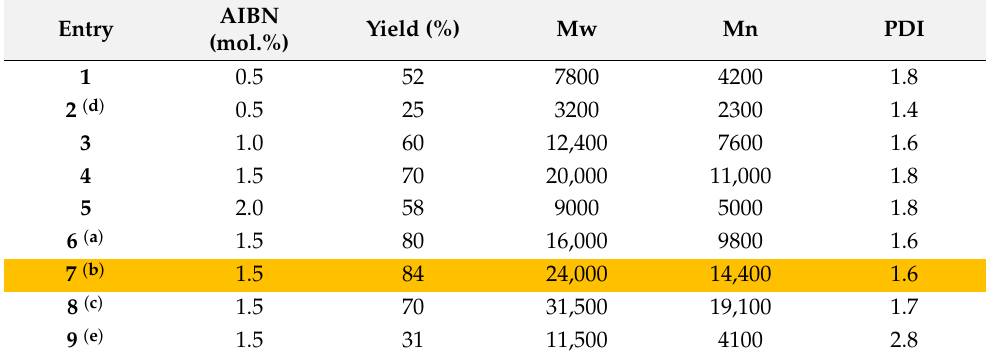
Table 1. Optimization of the copolymerization reaction between styrene and 9-(4-vinylphenyl) phenanthrene ( III